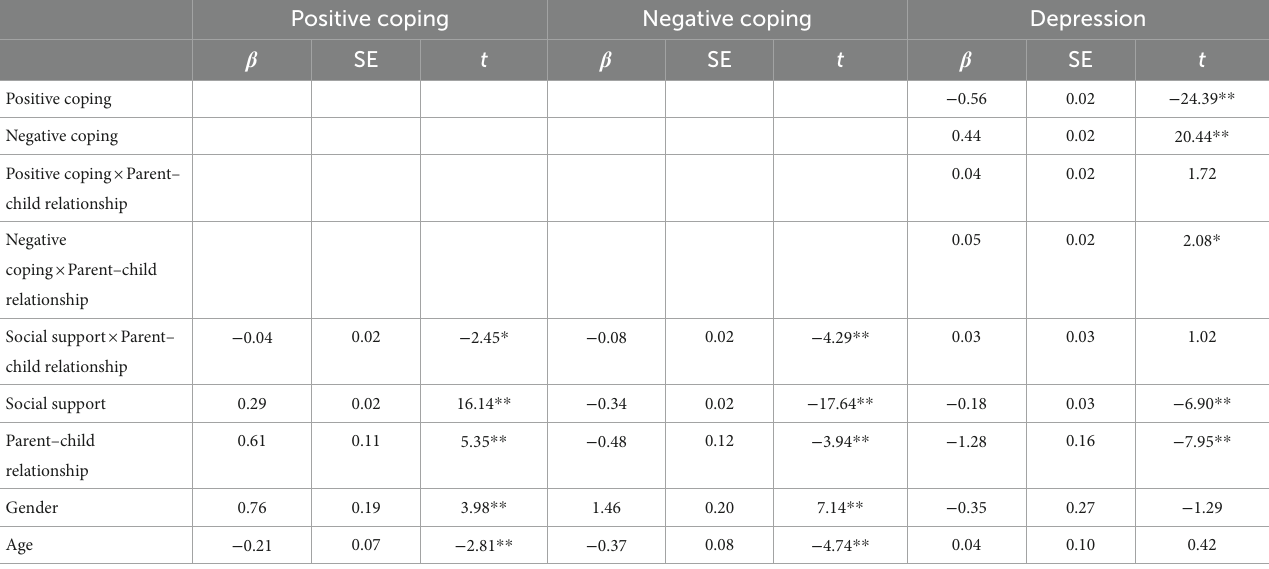
TABLE 5 Moderated mediation model